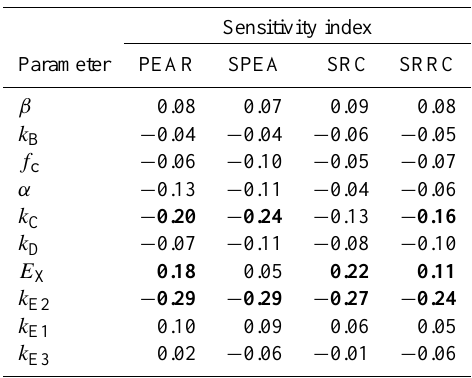
Table 3. Sensitivity indexes for each of the 10 calibration parame- ters vs. the NS coefficient. PEAR: Pearson product moment corre- lation coefficient, SPEA: Spearman coefficient, SRC: Standardized regression coefficient and SRRC: Standardized rank regression co- efficients. Index values in bold are statistically significant at 95% confidence level.